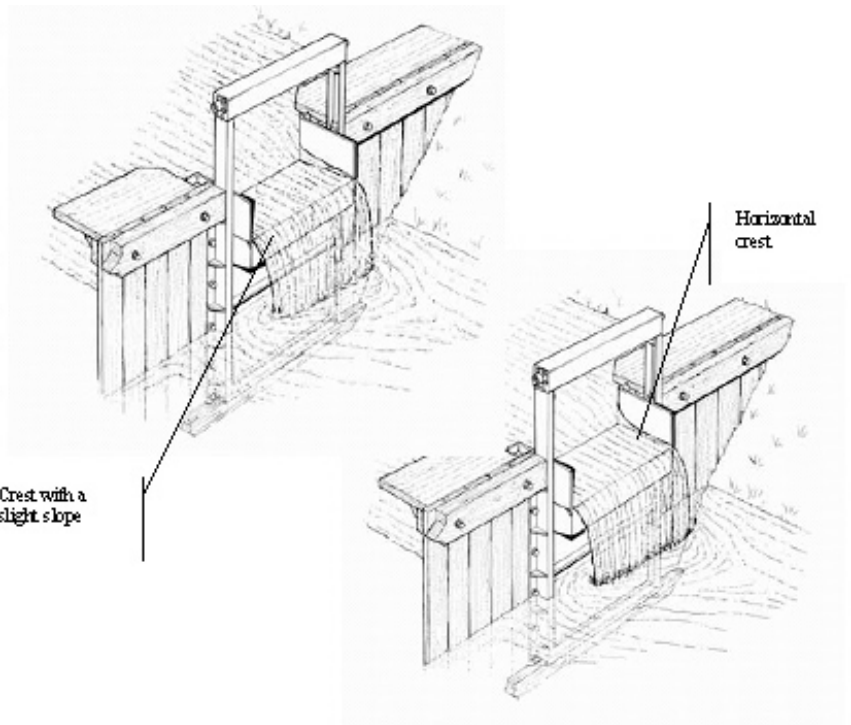
Figure 1 Romijn (upper left) and Hobrad (lower right) weirs